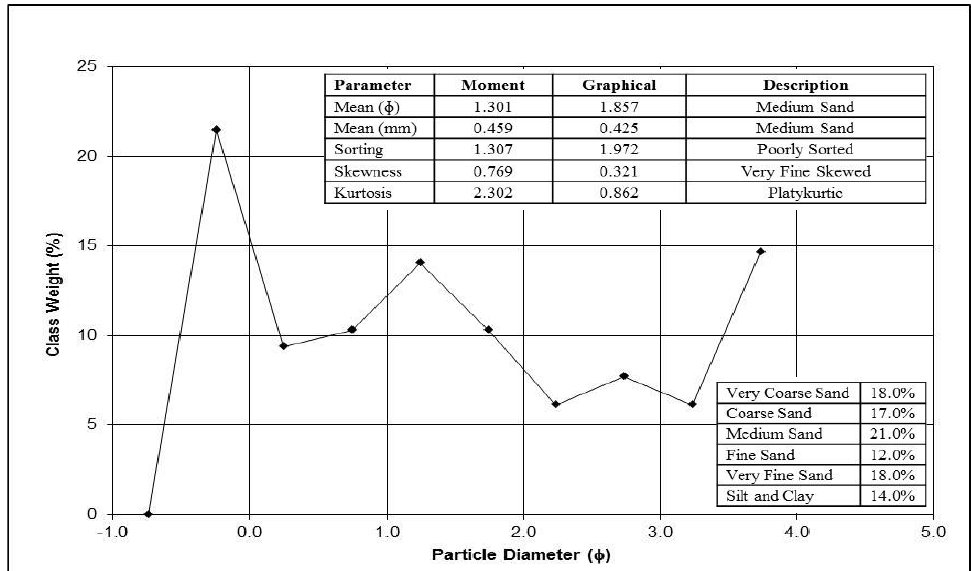
Figure 16. Average histogram and statistical parameters from surface sediments of the hotspot (A), with 32% composed of very fine sand and mud (silt and clay).